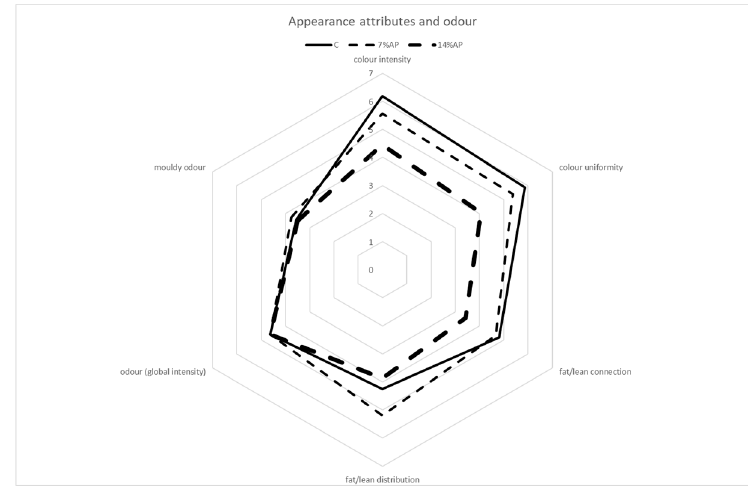
Figure 5. Sensory descriptive analysis. Appearance attributes and odour.